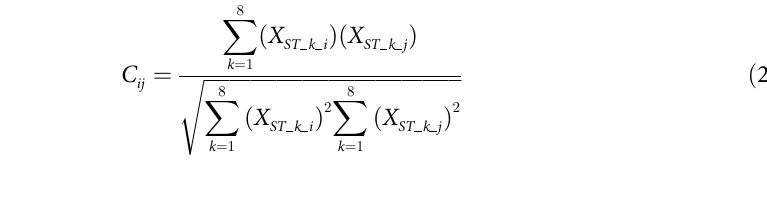
A correlation coefficient was then calculated based on the normalized molecular descriptors, as shown in Eq